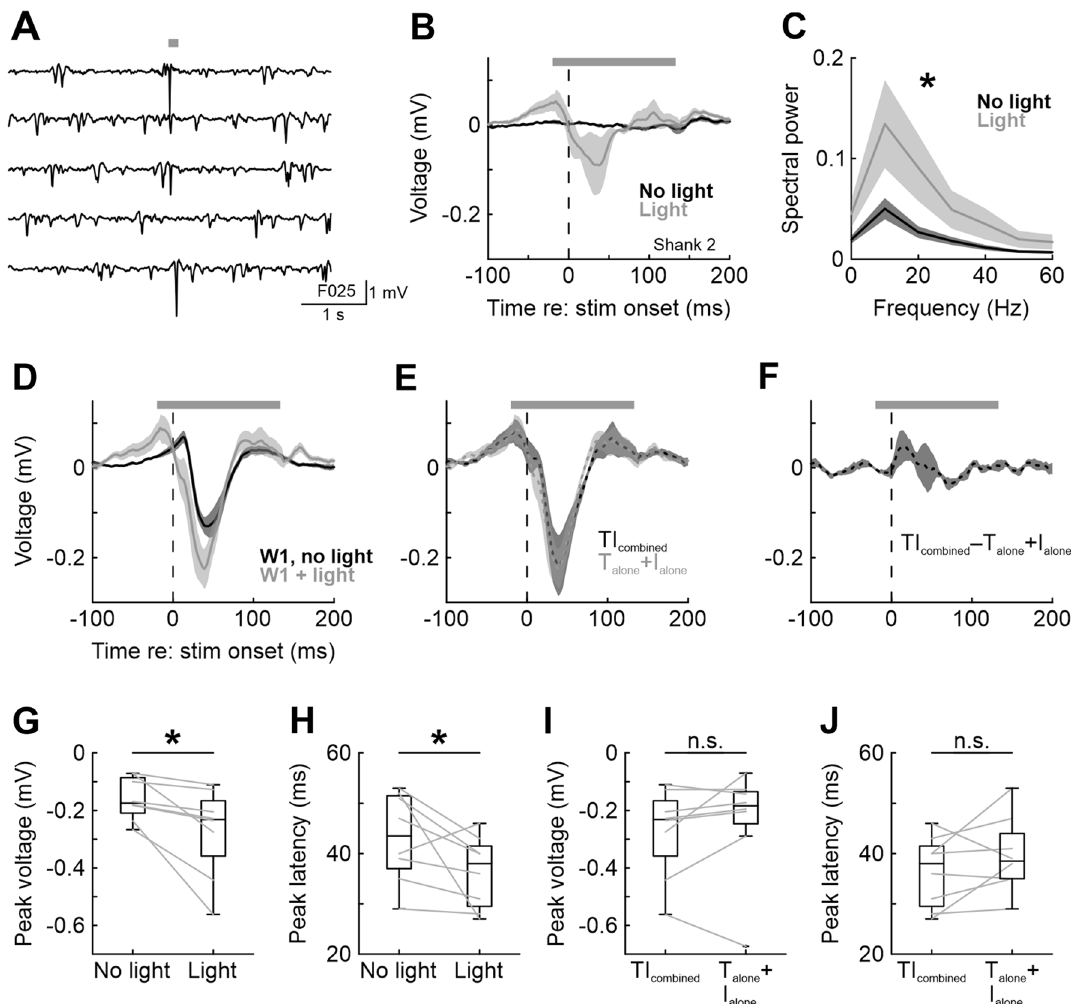
Figure 2. Optogenetic inhibition of PV+ interneurons affects ongoing brain activity and increases LFP responses to single-whisker deflections. ( A ) Five example traces from one animal showing background activity and light-evoked negative deflections of the LFP. The duration of light application is indicated by the horizontal gray bar. ( B ) Average LFP activity with and without light application (each trace averaged over n = 8 mice, 25 trials per stimulus, shading represents SEM over mice). In this and all other LFP panels of Fig. 2, LFP traces were high-pass filtered at 4 Hz to remove light artifacts (see Methods). ( C ) Spectrograms of 100 ms LFP segments during light application (light on for 153 ms, first 20 and last 33 ms omitted from analysis to exclude laser onset and offset artifacts). Light increases LFP power across all frequencies. ( D ) Average LFP responses in deep L2/3 to a single 30 Hz cosine pulse to whisker W1 with and without light application. ( E ) Comparison of the combined effect of whisker deflection and light application (dark gray, same trace as in ( D ) and the calculated summation of the LFP responses to whisker deflection and light application in isolation (light gray). ( F ) Difference between the two traces in E. ( G ) Boxplot of average peak amplitudes within the first 60 ms after stimulus onset; data from individual mice shown as gray lines. Corresponds to the traces shown in panel D. Asterisks in this and other panels indicate significant ( p < 0.05) differences; n.s., not significant. In this and all other figures of the main text, boxplots were constructed such that the box ranges from the 1st to the 3rd quartile of the data distribution, the horizontal line represents the median, and the whiskers encompass either the entire data distribution or extend until 1.5 times the interquartile range, whichever is shorter. In the latter case, more extreme data points (outliers) are shown as + signs. ( H ) Same as in G, but for peak latency. ( I ) As in G, but calculated from the data shown in E. ( J ) As in I, but for peak